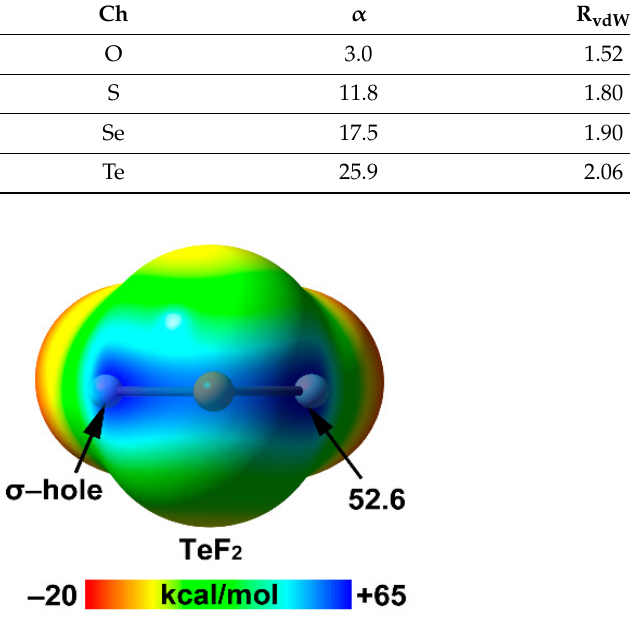
Figure 12. MEP surface of TeF 2 using the 0.001 a.u. isosurface at the MP2/def2-TZVP level of theory (energy in kcal/mol).